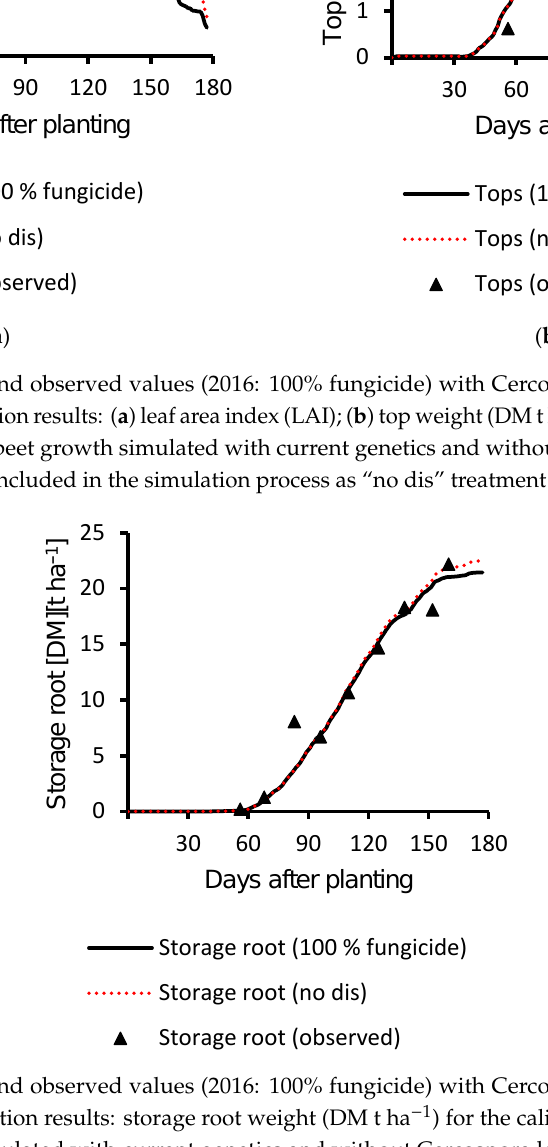
Figure 5. Simulated and observed values (2016: 100% fungicide) with Cercospora leaf spot ratings included in the simulation results: storage root weight (DM t ha −1 ) for the calibration treatment with sugar beet growth simulated with current genetics and without Cercospora leaf spot disease ratings being included in the simulation process as “no dis” treatment. Table 4. Detailed statistics for simulated and observed values of LAI (m 2 m −2 ), top weight (DM) kg ha −1 , and storage root weight (DM) kg ha −1 for the calibration treatment (100% fungicide in 2016).